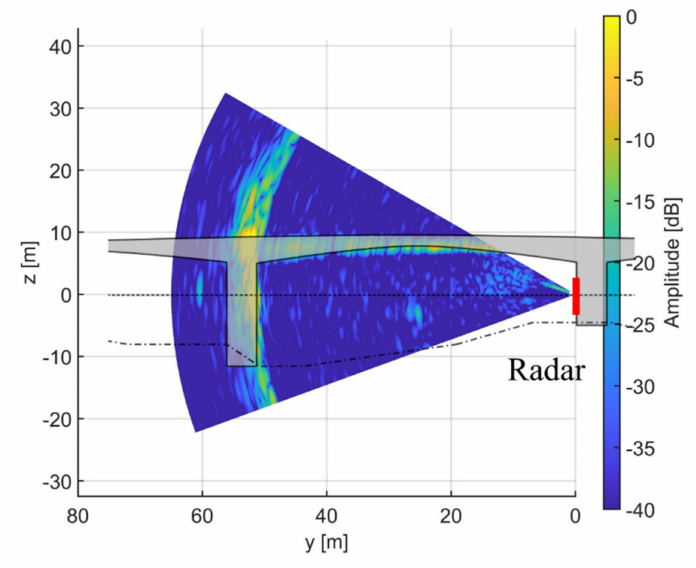
Figure 22. Radar image with vertical GB-SAR focused on the plane x (cid:3404) 0 m .